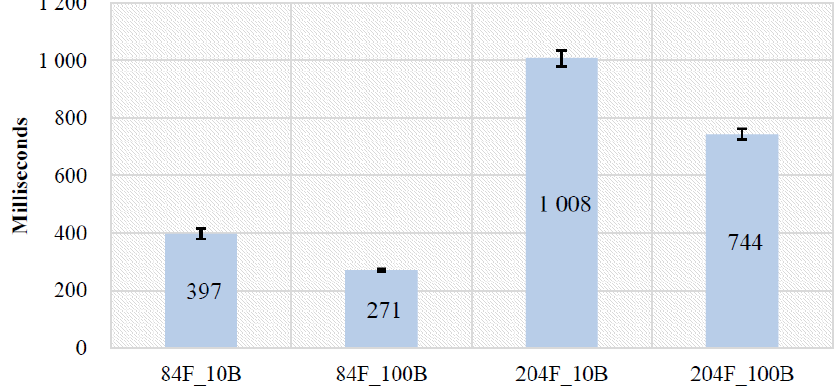
Figure 8. Effects of low battery on Samsung S4 (lower is better).